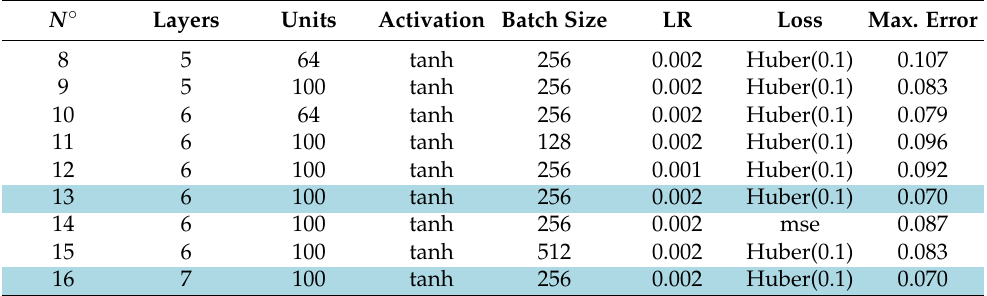
Table 5. Results of different models for maximum heights with the sigmoid activation function in the output layer and the ReduceLROnPlateau callback. Blue rows are models with good results that will be use in ensemble models.